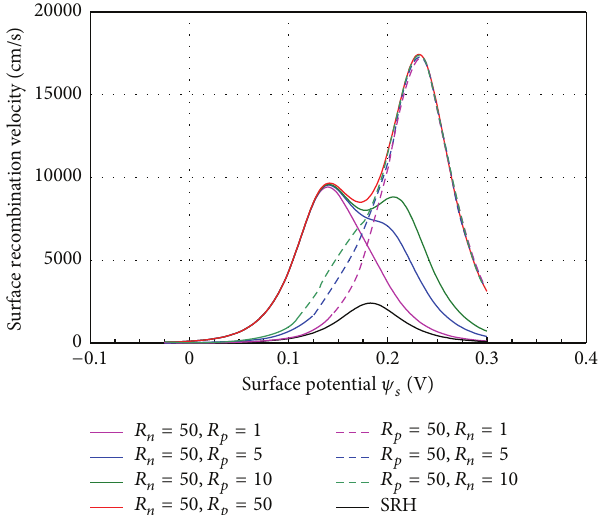
Figure 5: Effective surface recombination velocity versus surface potential for an injection level Δ𝑛(𝑊) = 10 10 /cm 3 , 𝐸 assuming 𝜎 𝑛 = 𝜎 0 𝑛 and 𝜎 𝑝 = 𝜎 0 𝑝 and different combinations of 𝑅 𝑛 and 𝑅 𝑝 .